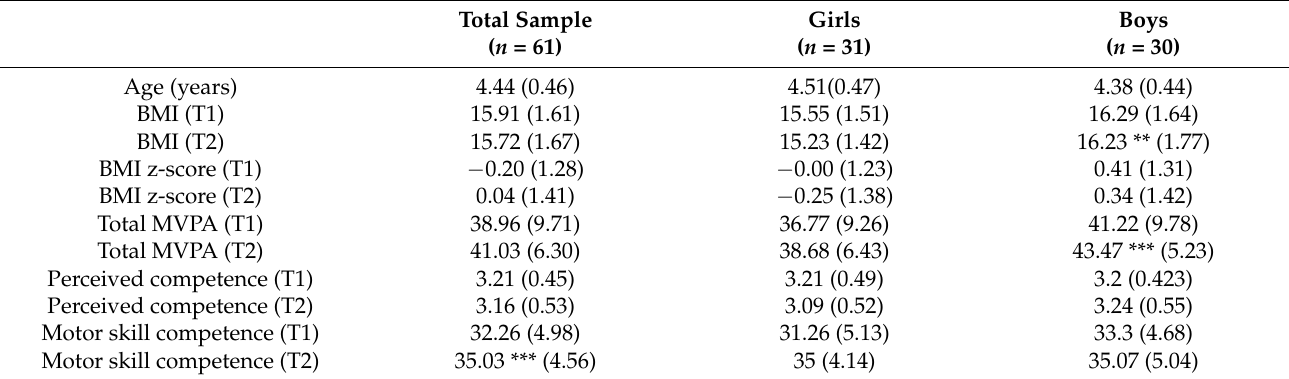
Table 1. Descriptive statistics (means and standard